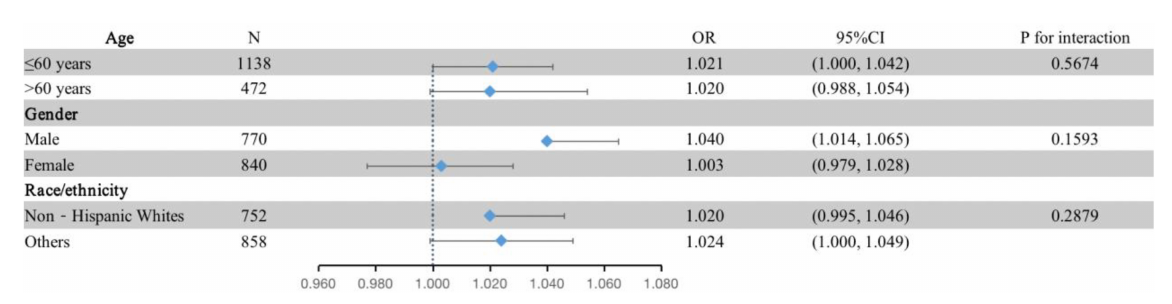
accuracy of the data analysis. All analyses are made by statistical software R (R Foundation) 3 and Empower Stats. 4 P -value